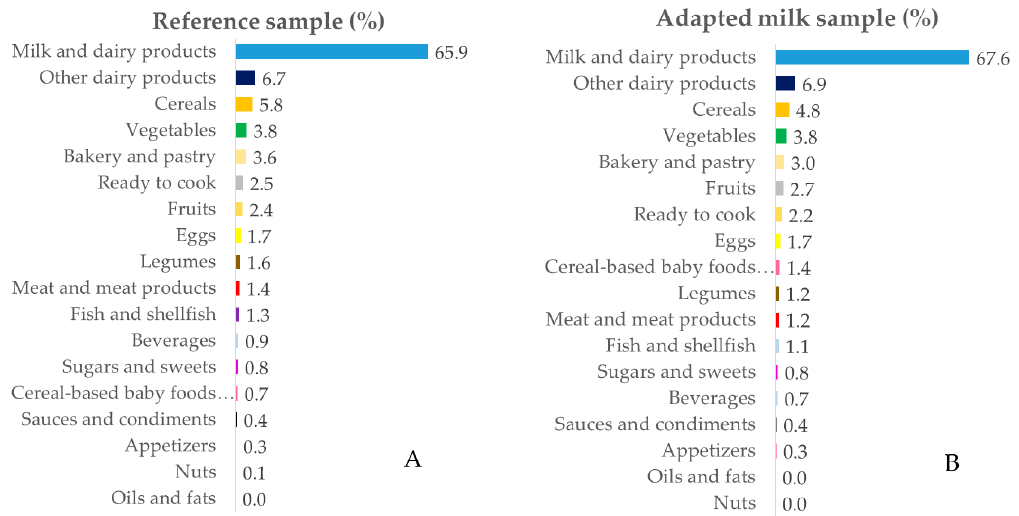
Figure 1. Percentage of the 18 food groups sources, in terms of the total c alcium intake (%), among the reference sample ( A ) and the adapted milk consumer sample ( B ) of the Spanish Pediatric Population (EsNuPI) study.